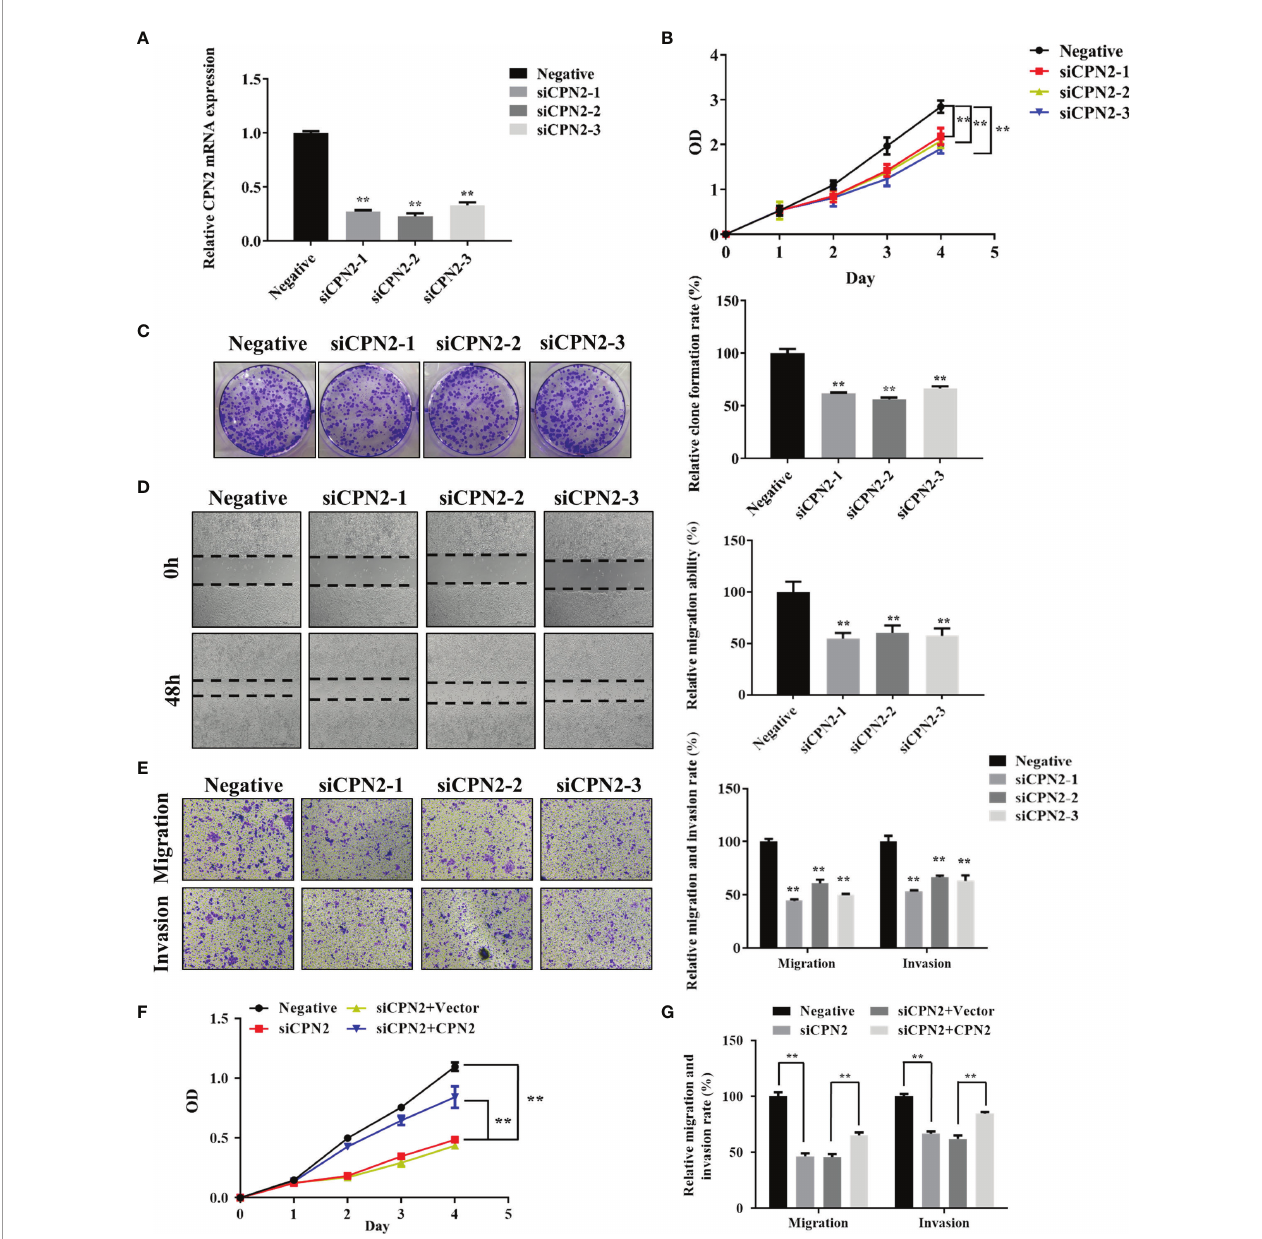
FIGURE 8 | CPN2 knockdown signi fi cantly inhibited lung cancer cell proliferation, migration, and invasion. (A) The knockdown expression of CPN2 was con fi rmed by qRT-PCR in lung cancer cells. (B) CCK-8 assay was used to examine the effect of CPN2 knockdown on proliferation in lung cancer cells. (C) Colony formation assays were used to examine the effect of CPN2 knockdown on growth in lung cancer cells. (D) Wound healing assay was used to determine the motility of CPN2 knockdown in lung cancer cells. The quanti fi cation of migrated cells is shown in the right panel. (E) Transwell assay was used to examine the effect of CPN2 knockdown on migration and invasion in lung cancer cells. The quanti fi cation of migrated cells is shown in the right panel. (F) CCK-8 assay was used to detect the effect of CPN2 overexpression on proliferation in lung cancer cells with CPN2 knockdown. (G) Transwell assay was used to detect the effect of CPN2 overexpression on migration and invasion in lung cancer cells with CPN2 knockdown. All data represent the mean ± SD of three independent experiments. ** P <